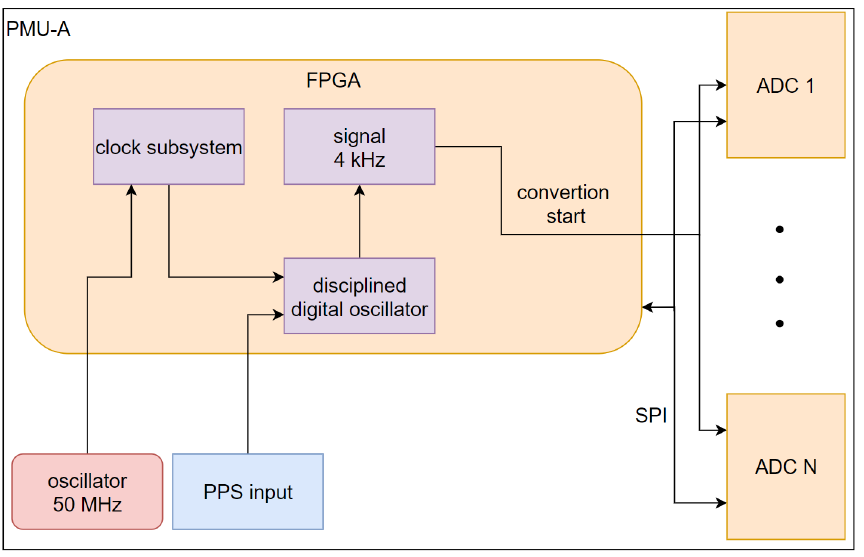
Figure 1. Block scheme of sampling signal generation in PMU-A.